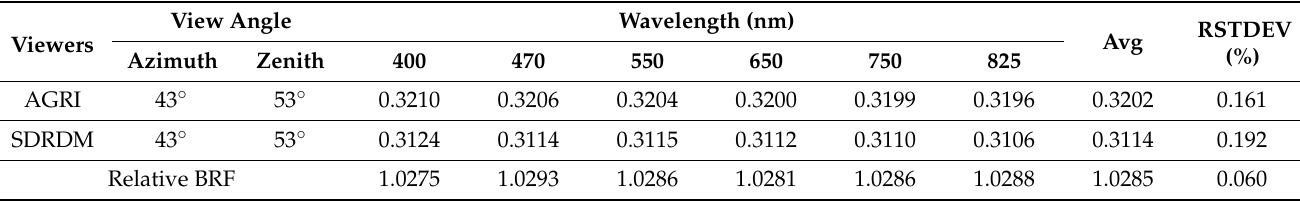
Table 1. Relative BRF data of different